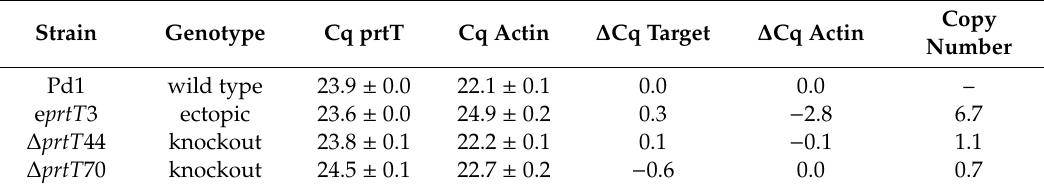
Table 2. Estimation of the number of T-DNA copies that have been integrated into the genome of the